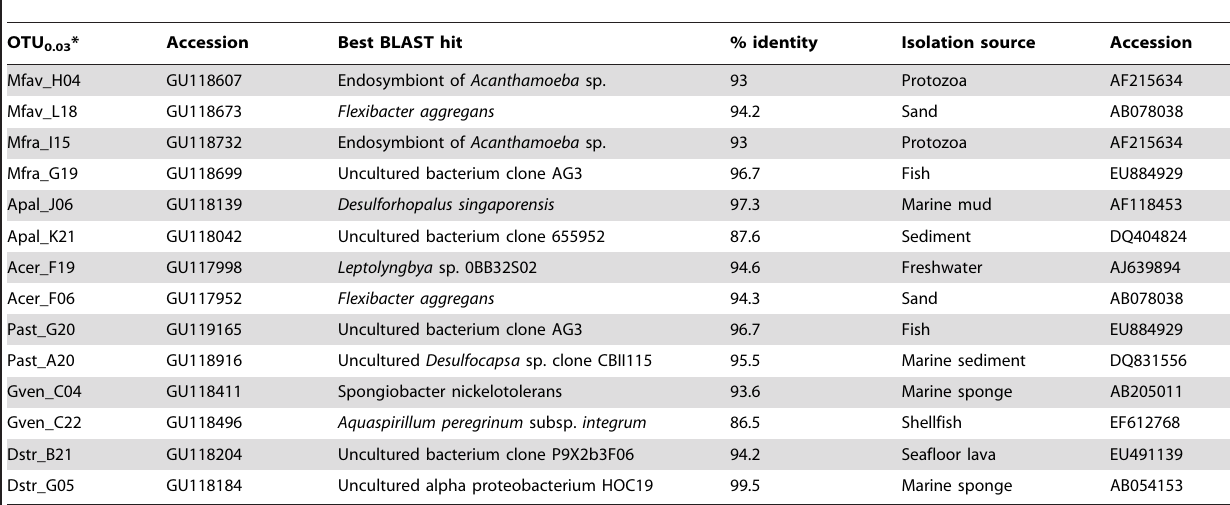
Table 3. Best non-coral associated BLAST hits of most abundant OTUs isolated from corals.